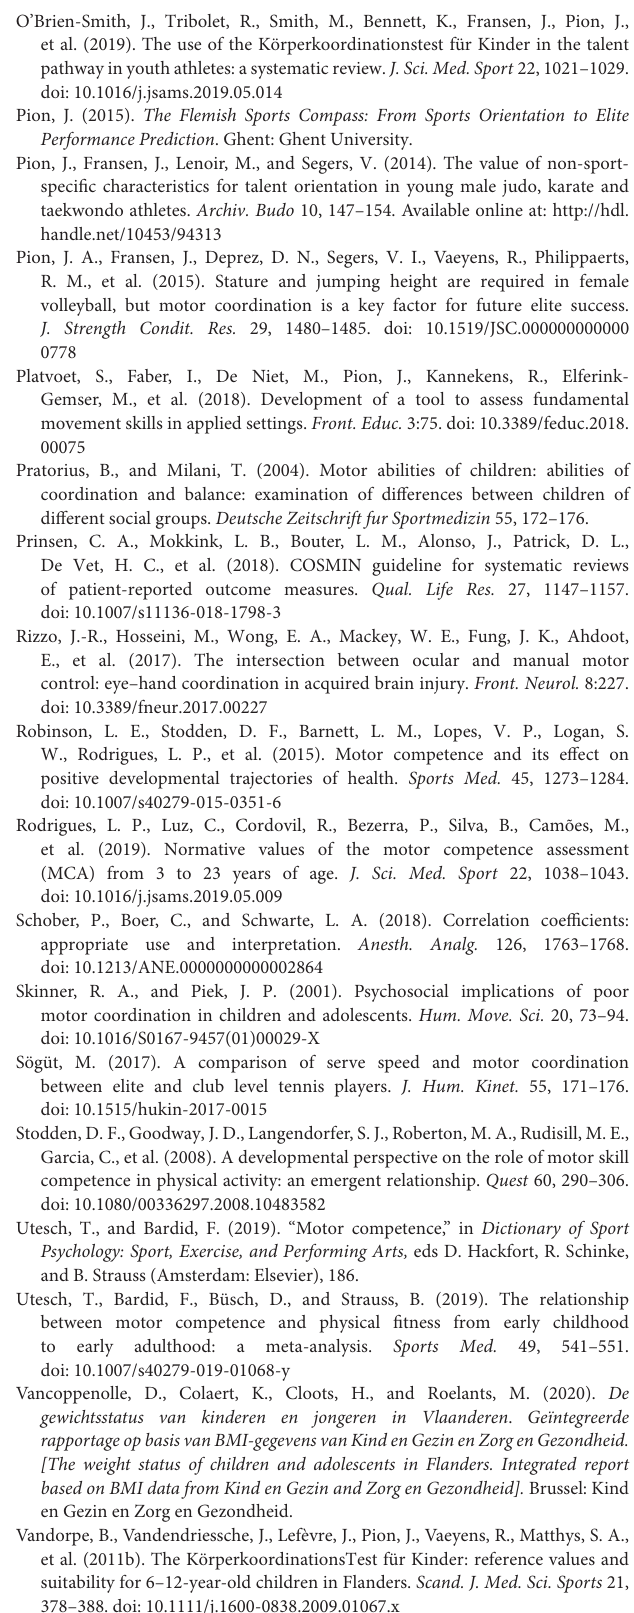
physical fitness and coordination of young figure skaters of different levels. Int. J. Sports Med. 37, 531–538. doi: 10.1055/s-0042-10 0280 Norjali Wazir, M. R. W., Mostaert, M., Pion, J., and Lenoir, M.